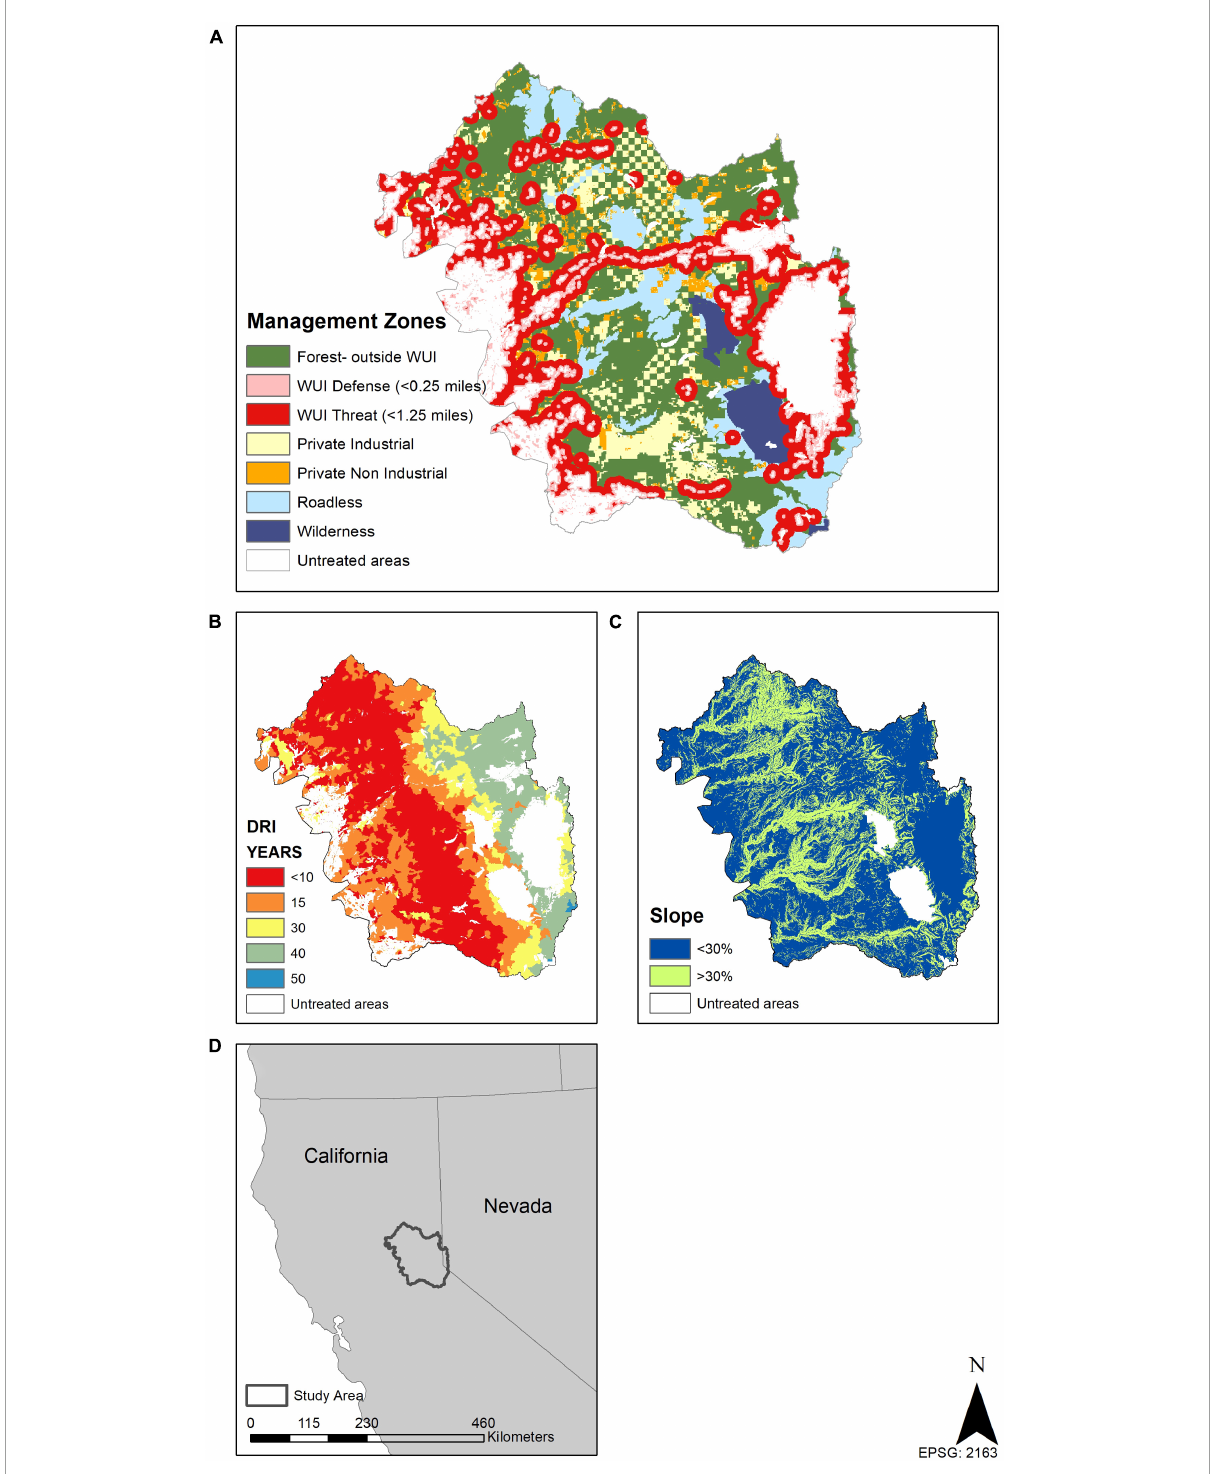
FIGURE1 Management zones (A) , historic fire return intervals (B) lumped by climate class and used to set scenario treatment amounts; and slopes (C) all influenced treatment prescriptions. Study area location within the USA (D) . Forested areas that are within 400 m of urban areas are called wildland urban interface (WUI) Defense areas, and those within 2000 m are WUI Threat areas. Forests outside of WUI areas in public ownership that were not legislatively restricted in some way are considered general forests, while roadless and wilderness areas are not allowed to have roads built within them and wilderness areas cannot have any mechanized equipment within